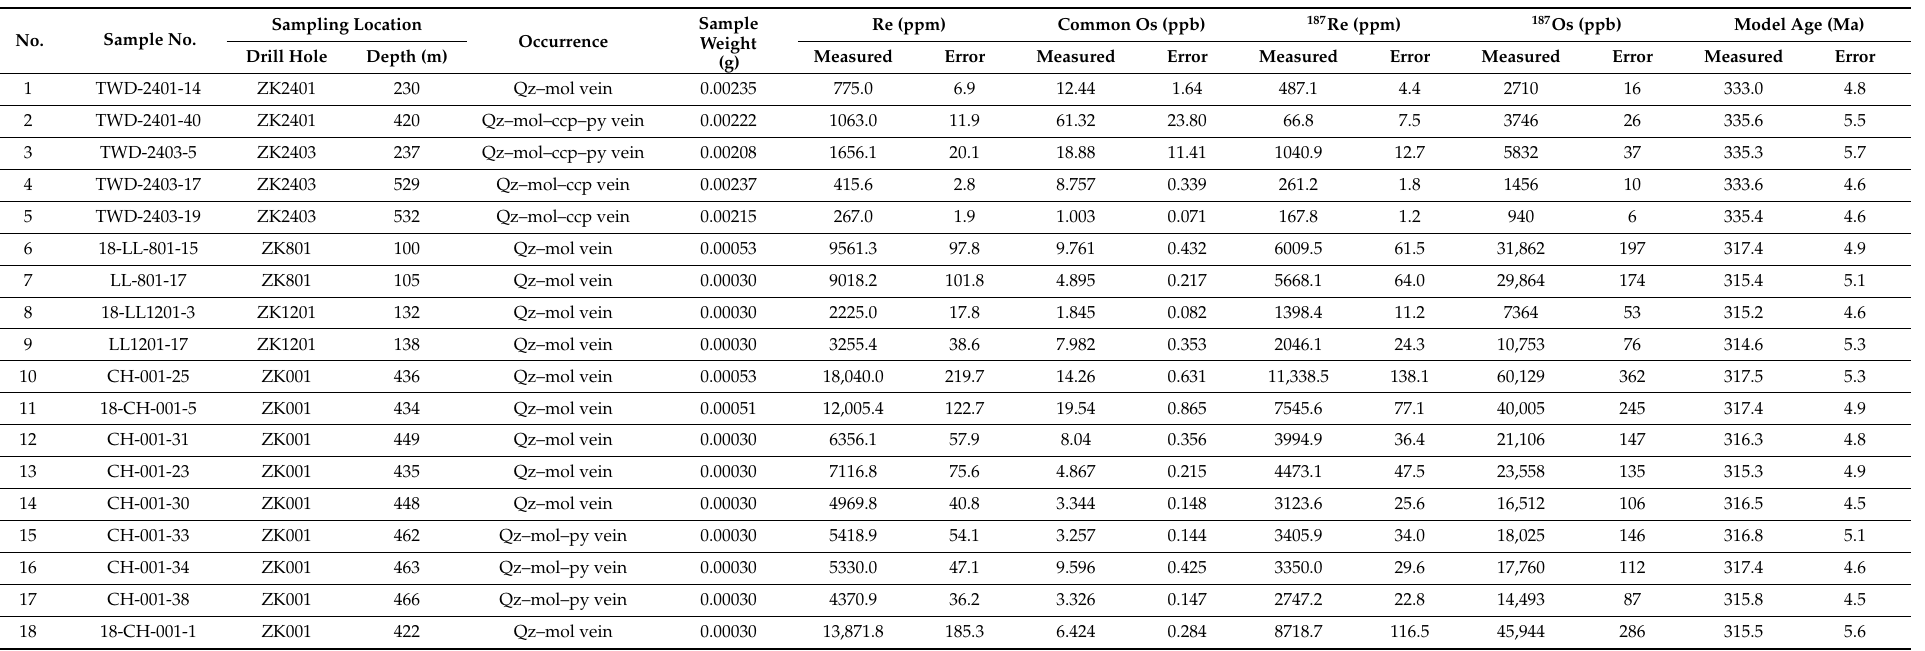
Table 2. Molybdenite Re–Os isotopic data for the Yandong porphyry Cu